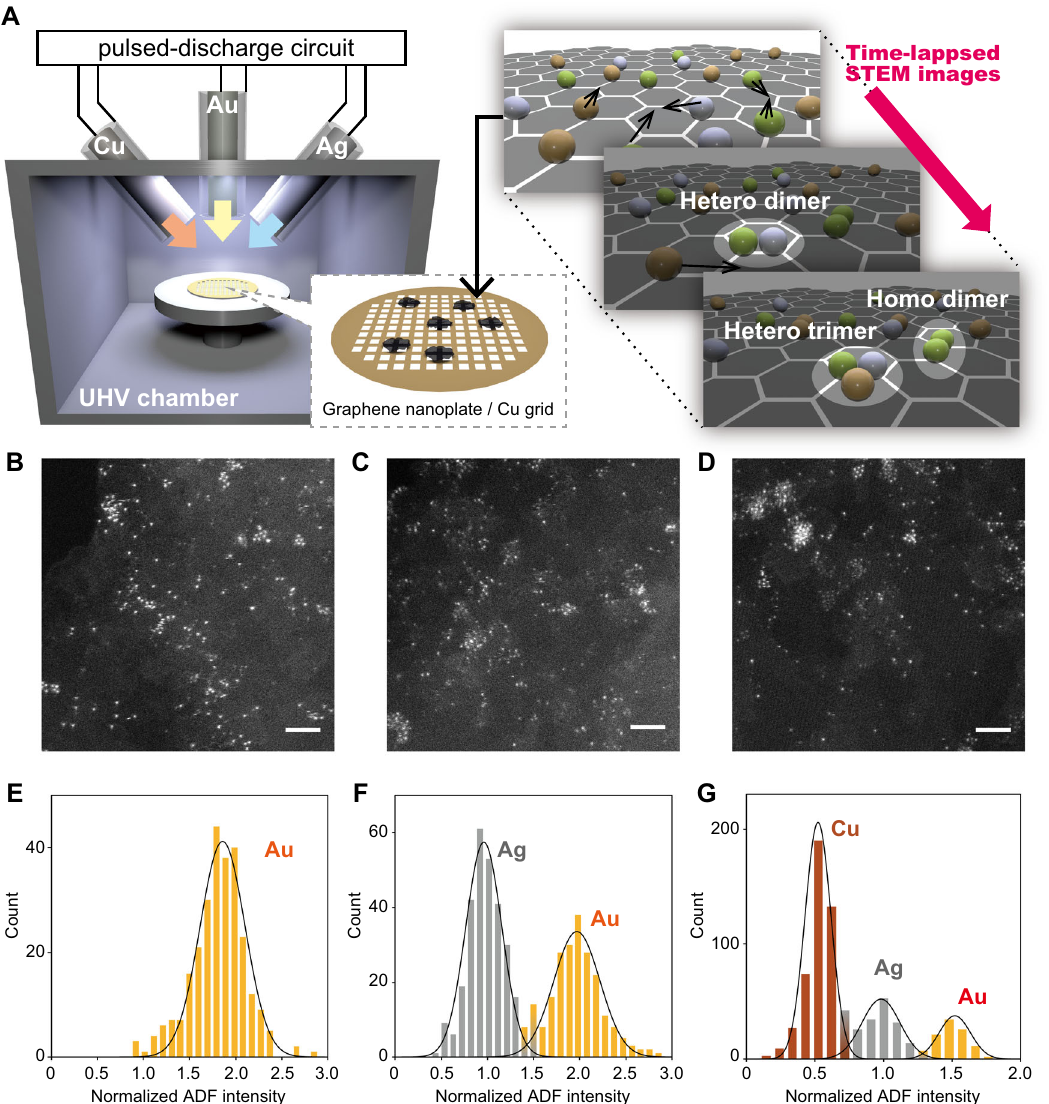
Fig. 1 A schematic illustration of the ADF-STEM images and the result of elemental identi fi cation in various samples. A A conceptual diagram of the process from sample preparation to STEM observation. During the observation, Au (yellow), Ag (gray), and Cu (brown) atoms move around randomly on the graphene as indicated by the arrows, forming not only homodimers but also heterodimers and heterotrimers. In this experiment, the atoms deposited on graphene by APD are captured using STEM. B – D ADF-STEM images of Au ( B ), Au/Ag bimetallic ( C ), Au/Ag/Cu trimetallic dispersion ( D ). Scale bar: 2 nm. E – G Histogram of the ADF intensity in monometallic Au ( E ), bimetallic Au/Ag ( F ), and trimetallic Au/Ag/Cu ( G